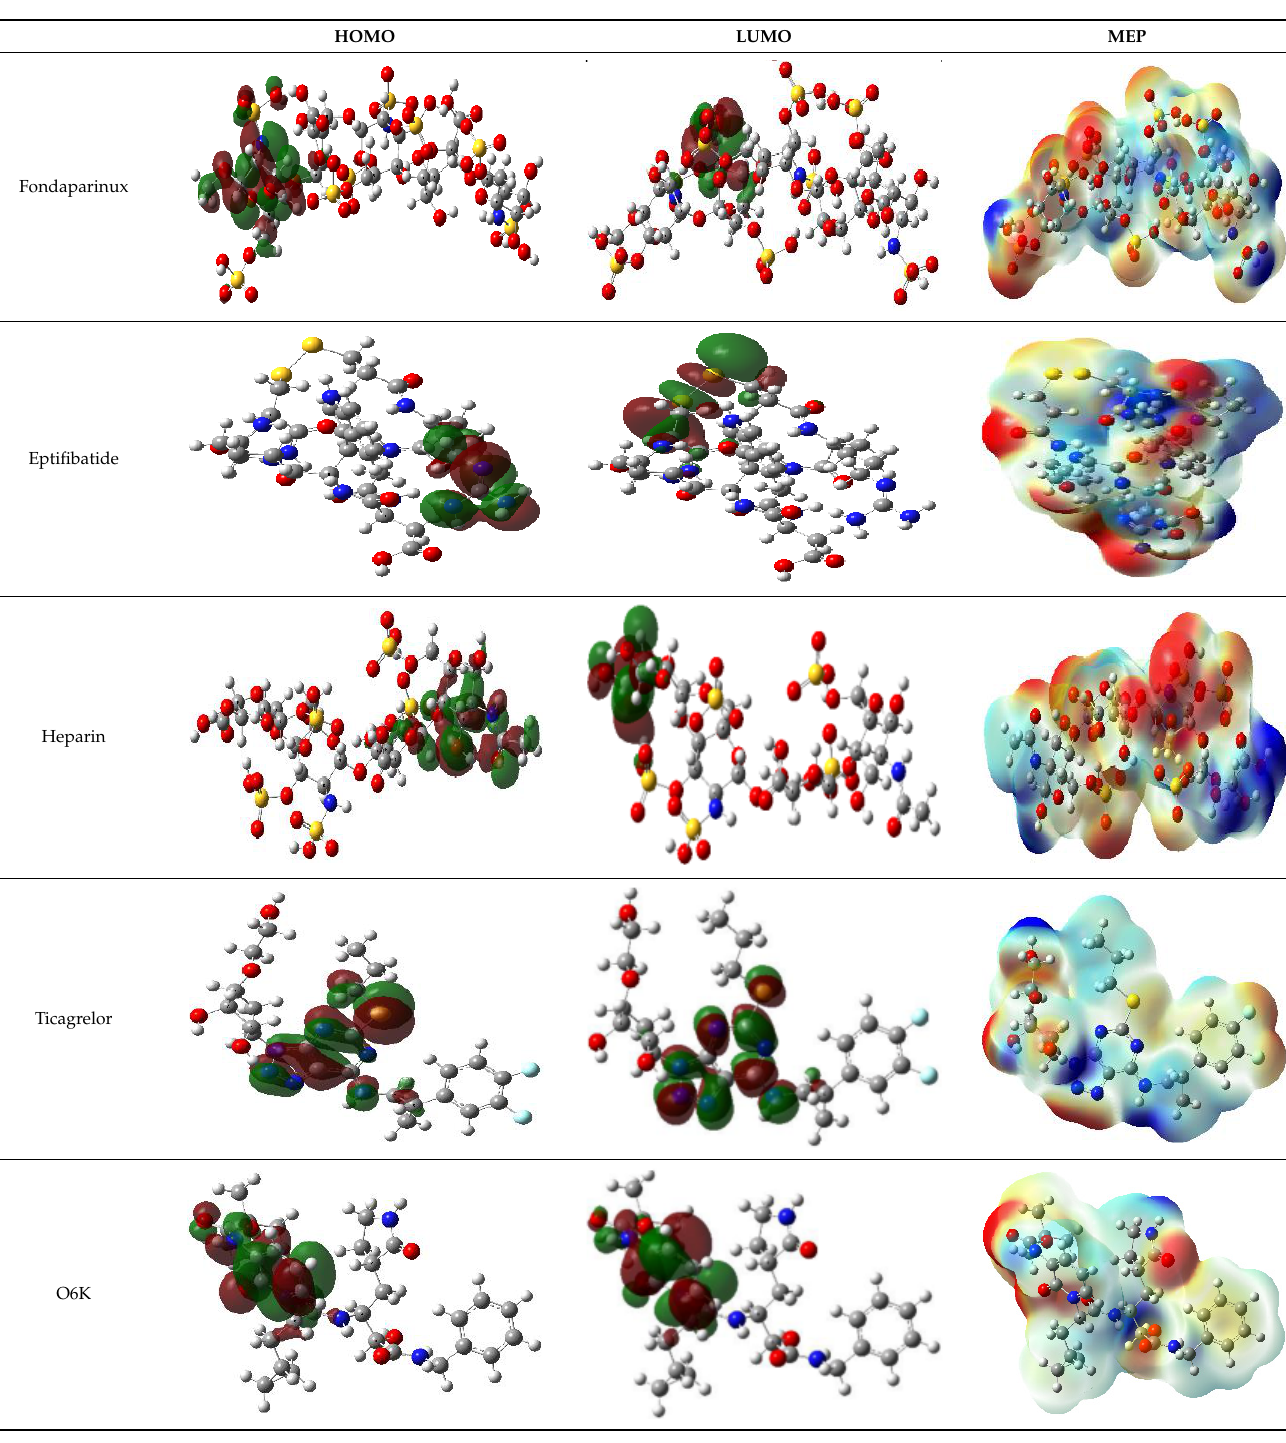
Table 4. Charge densities of outermost orbitals and MEP map of the most promising compounds optimized at the B3LYP/6-311G* level of theory.